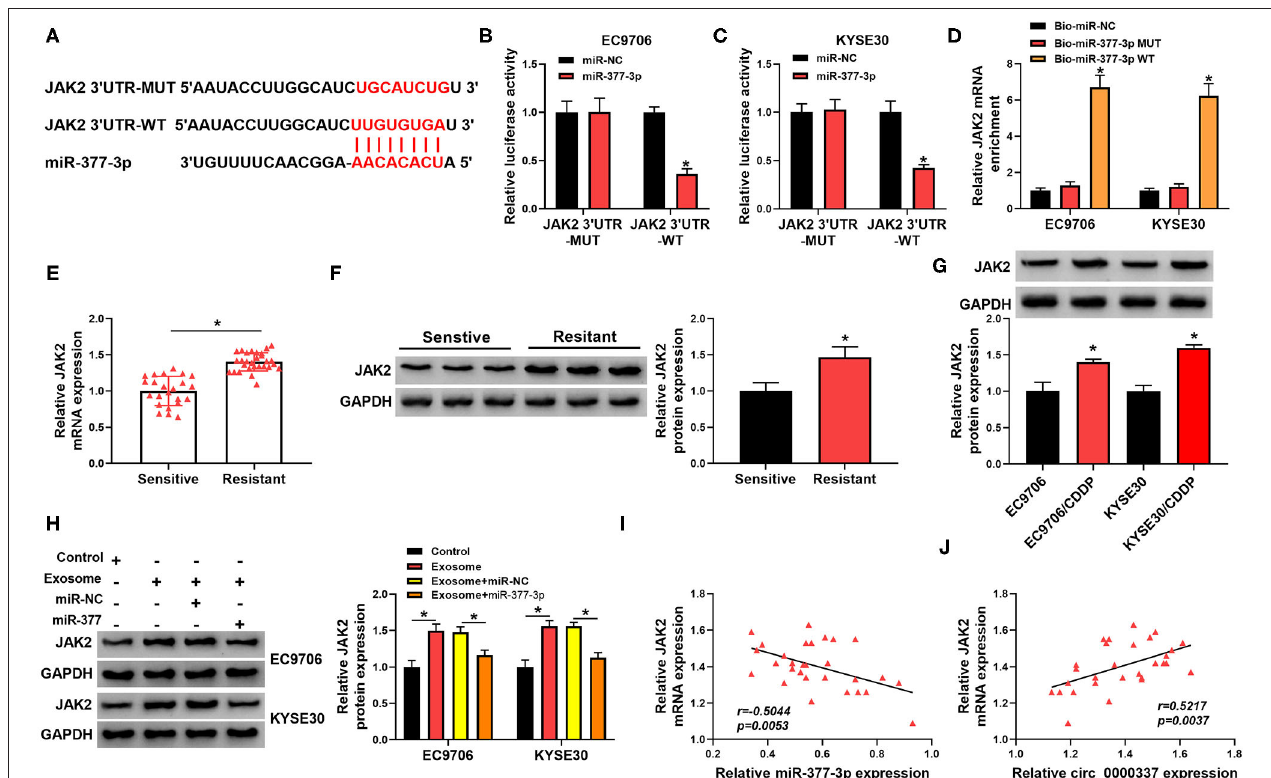
FIGURE 6 | MiR-377-3p interacted with JAK2 in esophageal cancer cells. (A) The putative binding site between miR-377-3p and JAK2 3 ′ UTR was presented by using Starbase. (B,C) The effect of miR-377-3p mimics on luciferase activity of JAK2 3 ′ UTR-WT and JAK2 3 ′ UTR-MUT reporters in EC9706 and KYSE30 cells were detected by a dual-luciferase reporter assay. (D) Relative levels of JAK2 in EC9706 and KYSE30 cell lysates captured by Bio-miR-377-3p WT, Bio-miR-377-3p MUT, or Bio-miR-NC. (E,F) The mRNA level and protein level of JAK2 were examined in the chemosensitive group ( n = 23) and the chemoresistant group ( n = 29). (G) JAK2 protein level was measured in EC9706, EC9706/CDDP, KYSE30, and KYSE30/CDDP cells. (H) JAK2 protein level was assessed in EC9706 and KYSE30 cells treated with control, exosome, exosome + miR-NC, and exosome + miR-377-3p. (I,J) The expression correlation of JAK2 with miR-377-3p and circ_0000337 in esophageal cancer was evaluated by Pearson correlation analysis. * P <